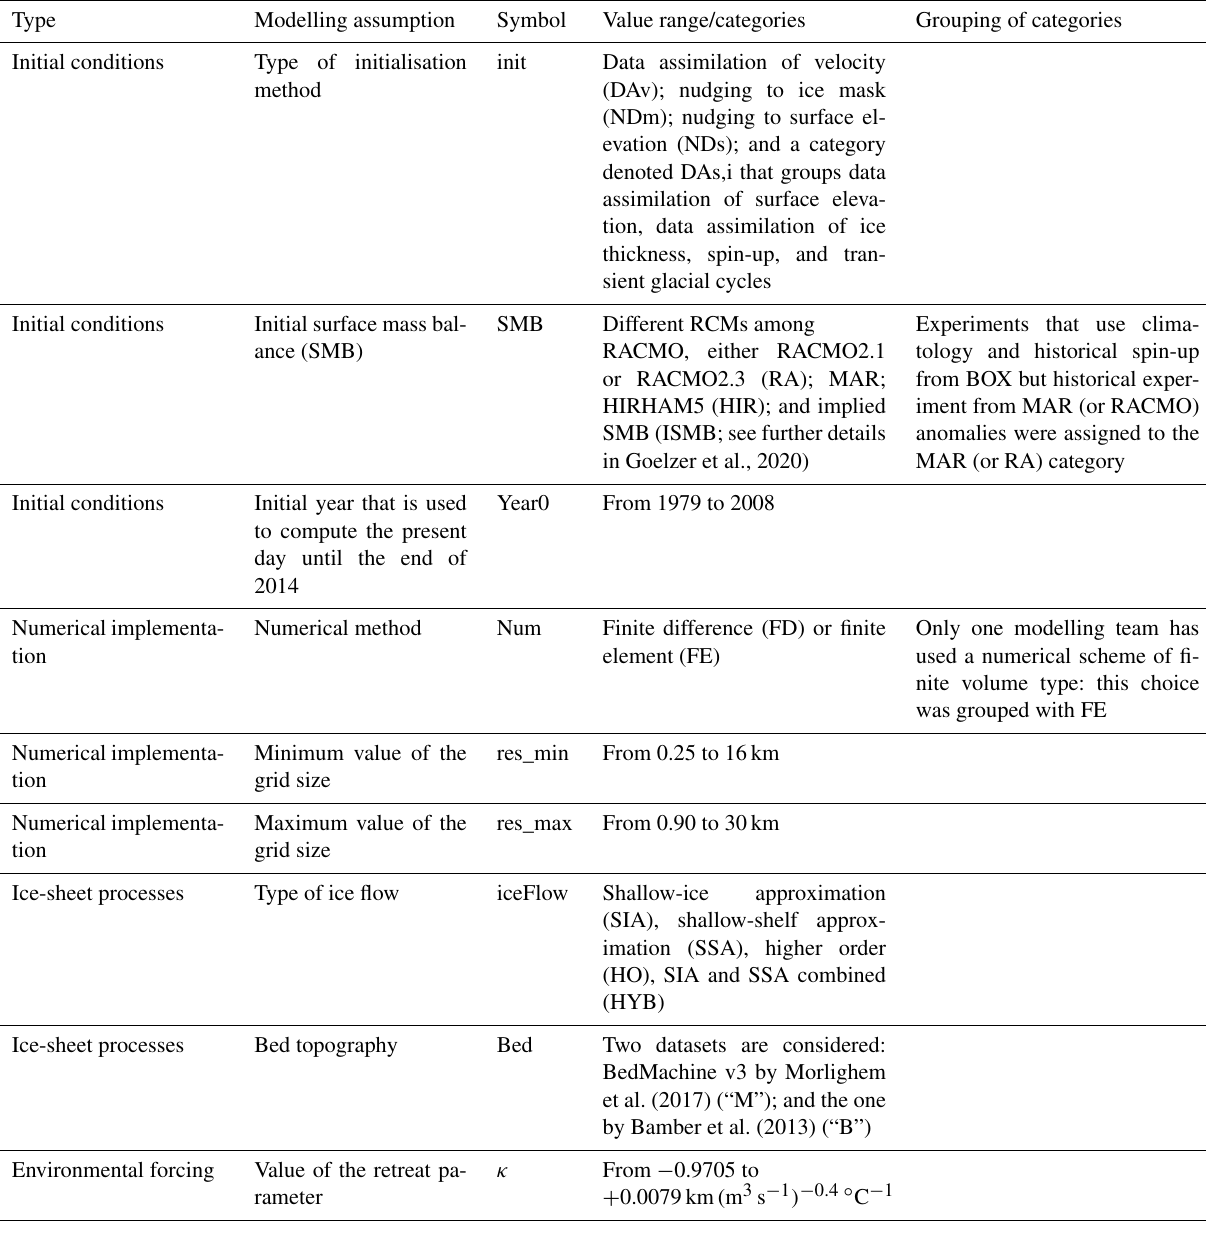
Table 1. Modelling assumptions considered in the MIROC5 RCP8.5-forced GrIS